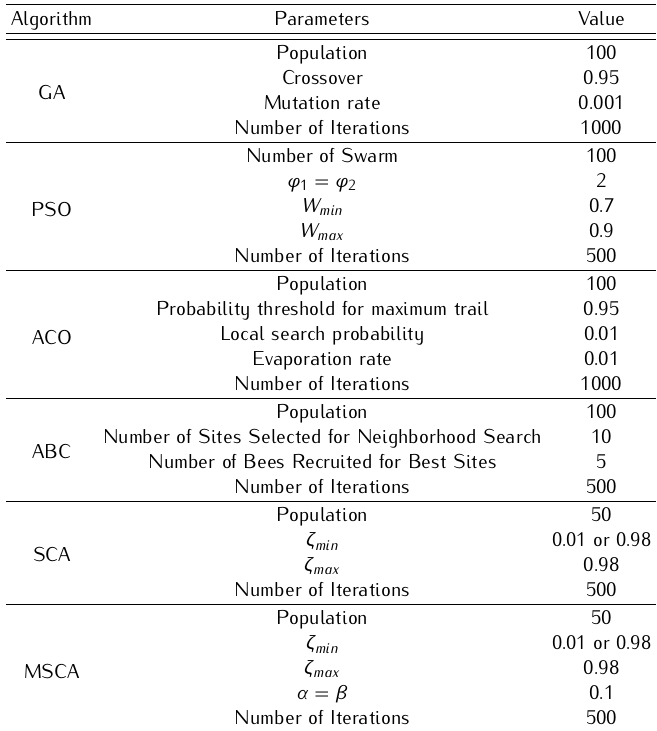
Table 2. Values of parameters of each of six